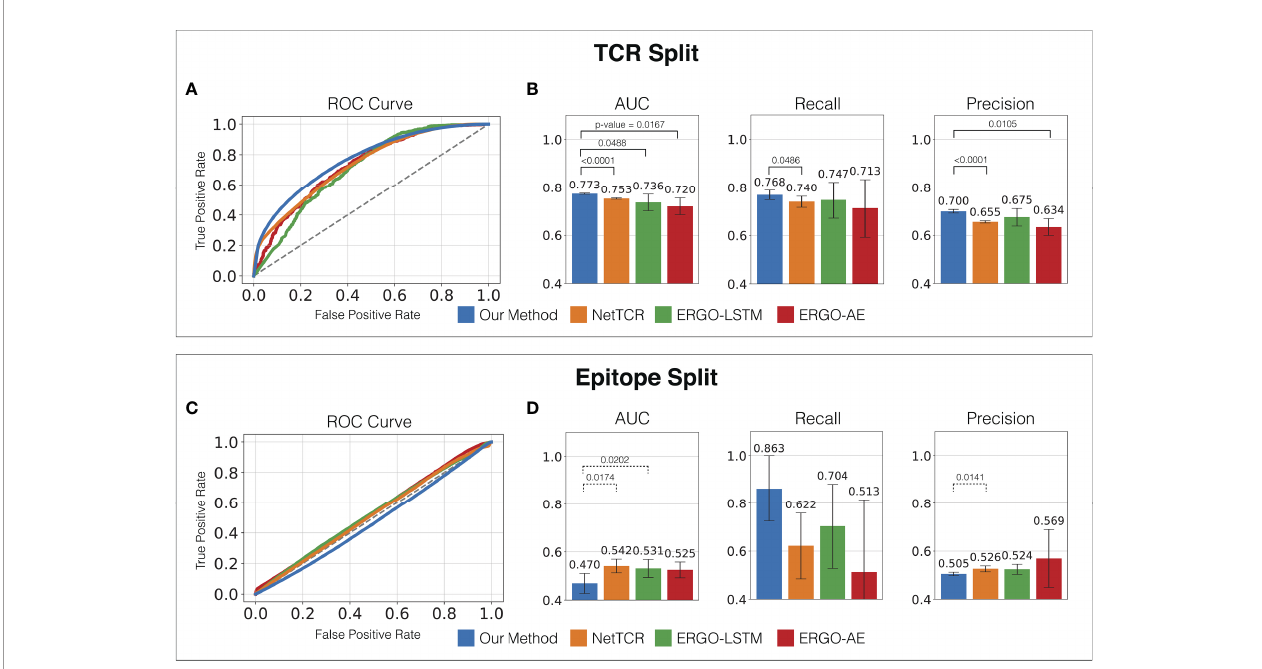
FIGURE 4 | Prediction performance of ATM-TCR and all other methods measured on the primary dataset. (A) ROC curve, (B) AUC, recall, and precision of the TCR split. (C) ROC curve, (D) AUC, recall, and precision of the epitope split. The averages across the 5-fold testing sets were reported. For each fold Youden ’ s Index was utilized on the ROC curve to determine the optimal cut-off point to measure recall and precision. One-sided paired t-test was performed to test if each AUC, recall, and precision of ATM-TCR was signi fi cantly greater than the others, or the others were signi fi cantly greater than ATM-TCR. When ATM-TCR was signi fi cantly better, we reported the p-value and indicated the two methods with solid line above the bar plots. When the others were signi fi cantly better, we reported the p- values and indicated the two methods with dashed line above the bar plots. If none of the directions were signi fi cant, we did not